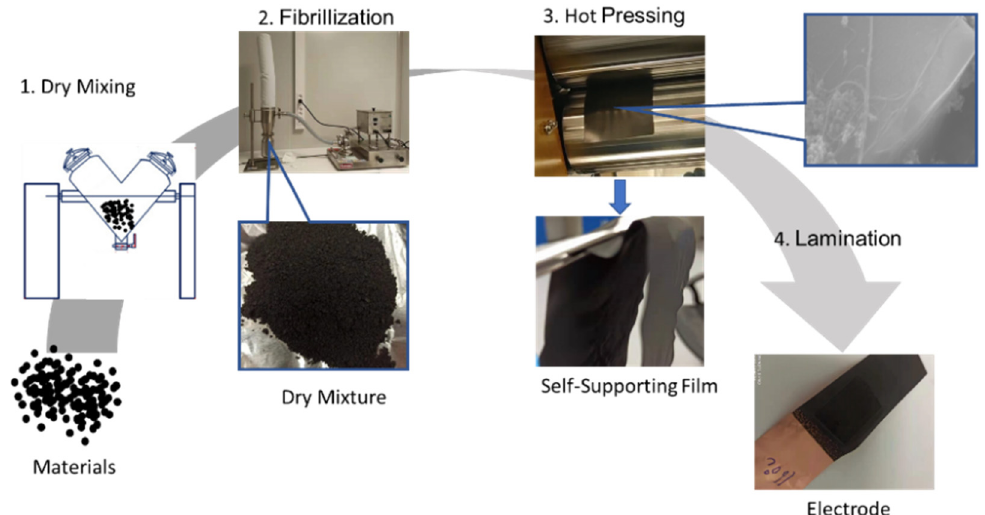
Figure 1. Schematic representation of SF graphite anodes fabrication process.